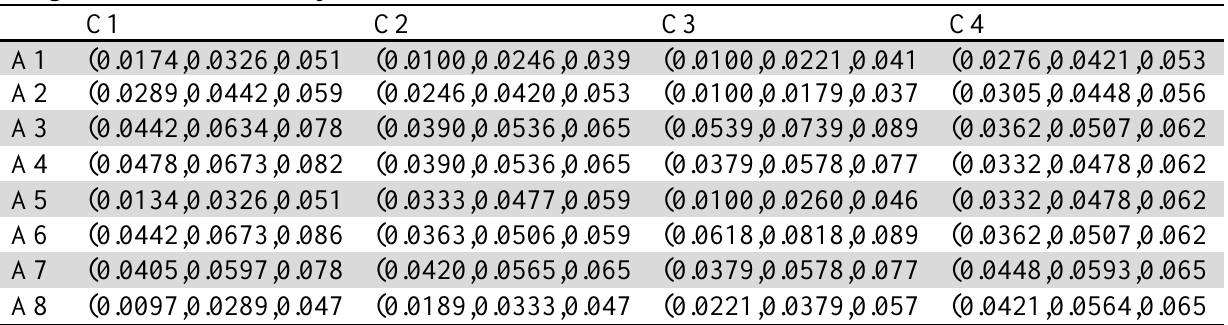
Weighted normalized fuzzy decision matrix for